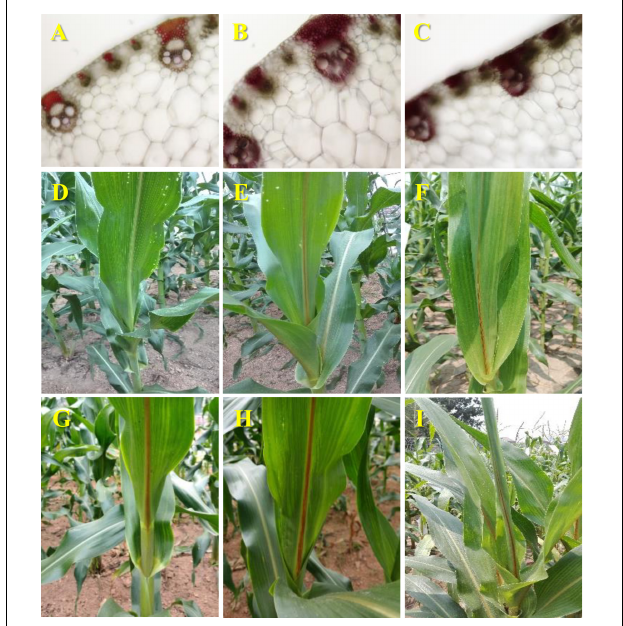
FIGURE 1 | Morphological characterization of the bm1-E mutants. Midribcross sections stained with acid phloroglucinolof the fourth leaf collected from 60-days old wild-type Z58 (A) , bm1-E1 (B) , and bm1-E2 (C) . Adaxial view of themidrib of 45-days old wild-type Z58 (D) , bm1-E1 (E) , bm1-E2 (F) , bm1 (G) , hybrid bm1 × bm1-E1 (H) , and hybrid bm1 × bm1-E2 (I) . Cross sections and adaxial view of the midribs from three